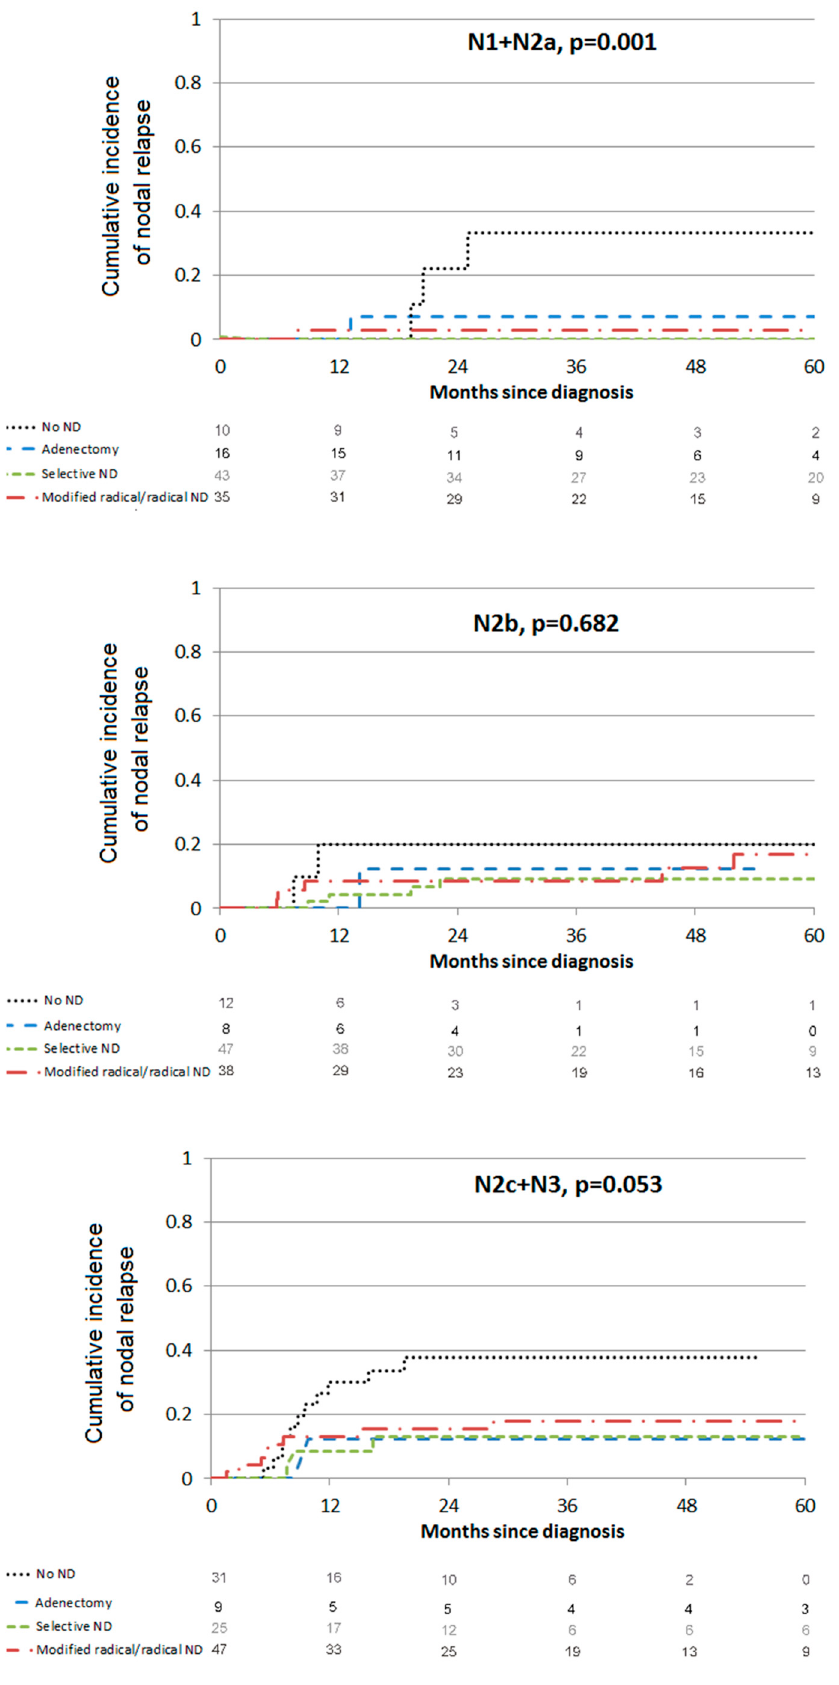
Figure 1. Relapse node.